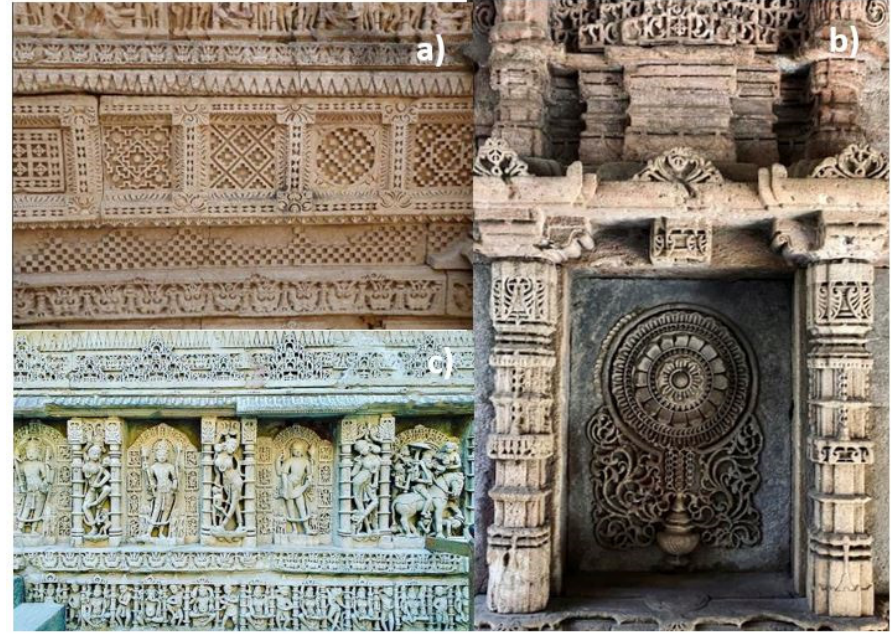
Figure 6. Major aesthetics features: ( a ) Ingenious geometric patterns https://www.shutterstock.com/image-photo/rani-ki-vav-stepwell-on-banks-1365740735, accessed on 20 July 2022; ( b ) floral motifs and filigrees http://modestryliving.com/2018/02/07/adalaj-stepwell-ahemdabad-travel/, accessed on 20 July 2022 and ( c ) voluptuous female figurines and male deities of Shaivism-Vaishnavism https://www.thrillophilia.com/tours/rani-ki-vav-patan, accessed on 20 July 2022. In Gujarat and Rajasthan, the stepwells were identified with mixed sculpt designs and features of Hindu symbolism and domes and arches from Islamic influences, reflecting religious tolerance [95]. Comparatively, those found in Gujarat were most intricate and ornamental in design [48]. Although the Adalaj stepwell (23.1667 ◦ N, 72.5801 ◦ E) has some of the finest stone carvings of any Indian well, many scholars consider the Navghan stepwell in Junagadh (21.523894 ◦ N, 70.471578 ◦ E) to be the successor of all stepwells